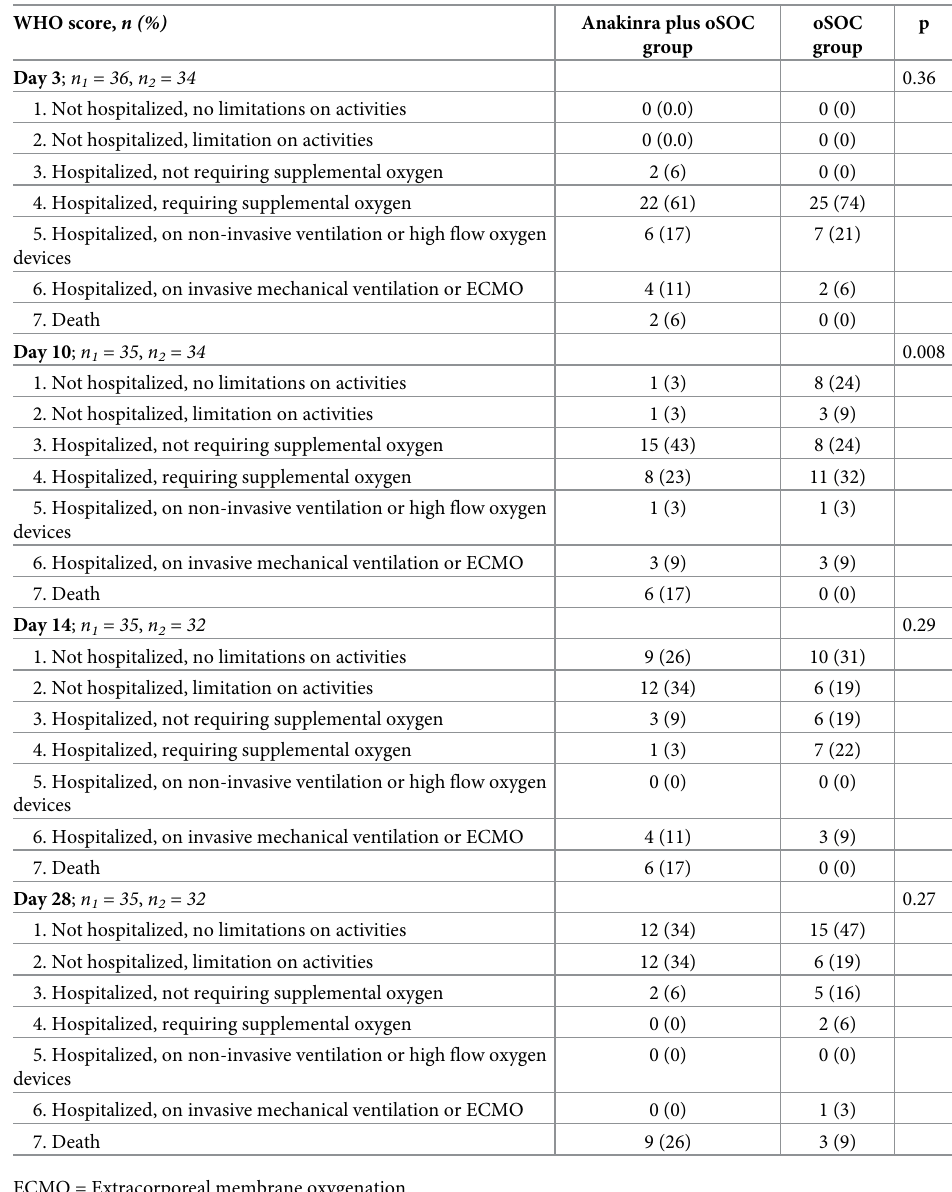
Table 4. Evolution of WHO scores across 28-day follow-up. WHO score, n